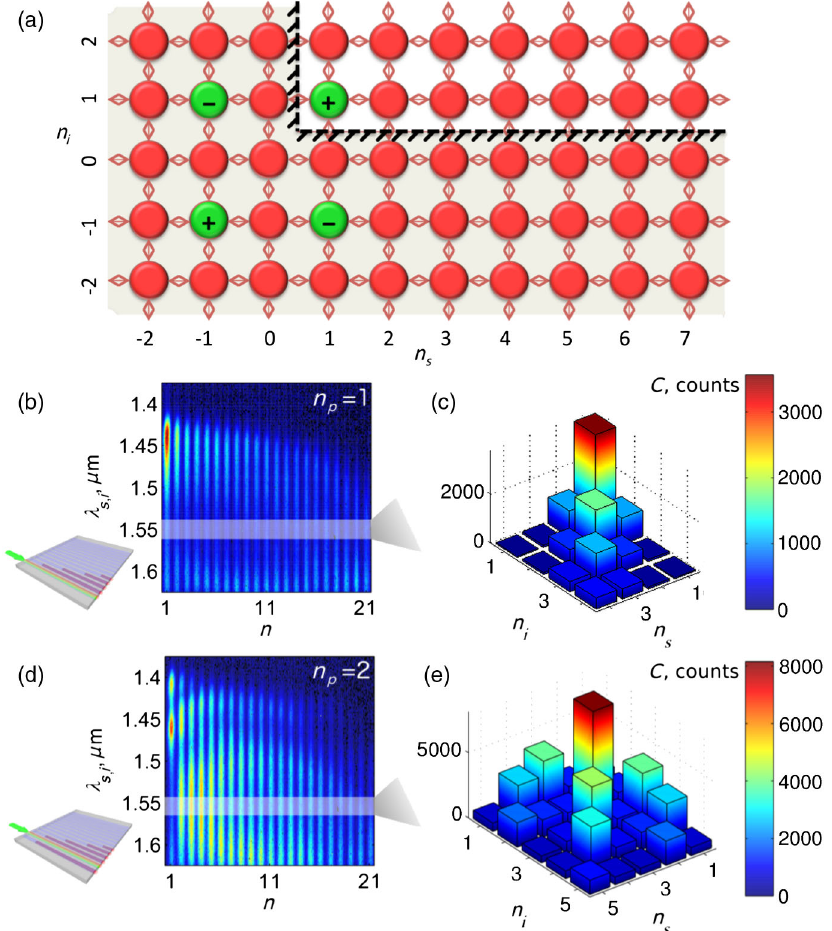
FIG. 3. (a) Lattice representation of the photon-pair states. Shading marks the image space beyond the array boundary, and green color with plus and minus signs marks the locations of real and virtual pump sources of biphotons. (b),(d) Spatial-spectral photon-pair output distributions and (c),(e) corresponding correlations using a spectral filter (gray area). (b),(c) The pump wavelength is λ 775 . 3 nm, and the pump is coupled to the first waveguide from the edge ( n p ¼ and the pump is coupled to the second waveguide from the edge ( n p ¼ 2 ). Different pump wavelengths are selected to achieve maximally nonclassical